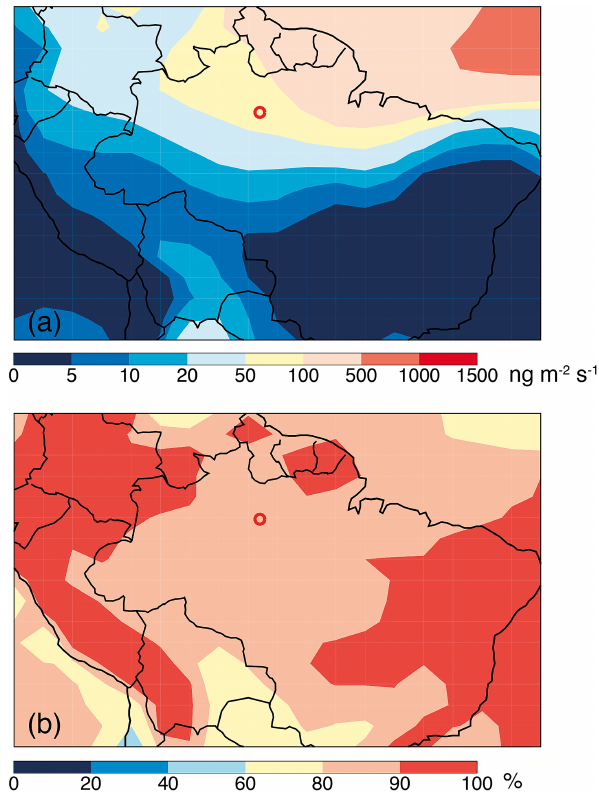
Figure 7. GEOS-Chem model results representing: (a) dust aerosol deposition flux and (b) contribution of wet dust deposition (rain out and wash out) relative to total deposition flux. Both data products were calculated from January to April 2014. The location of the ATTO site is represented by a red